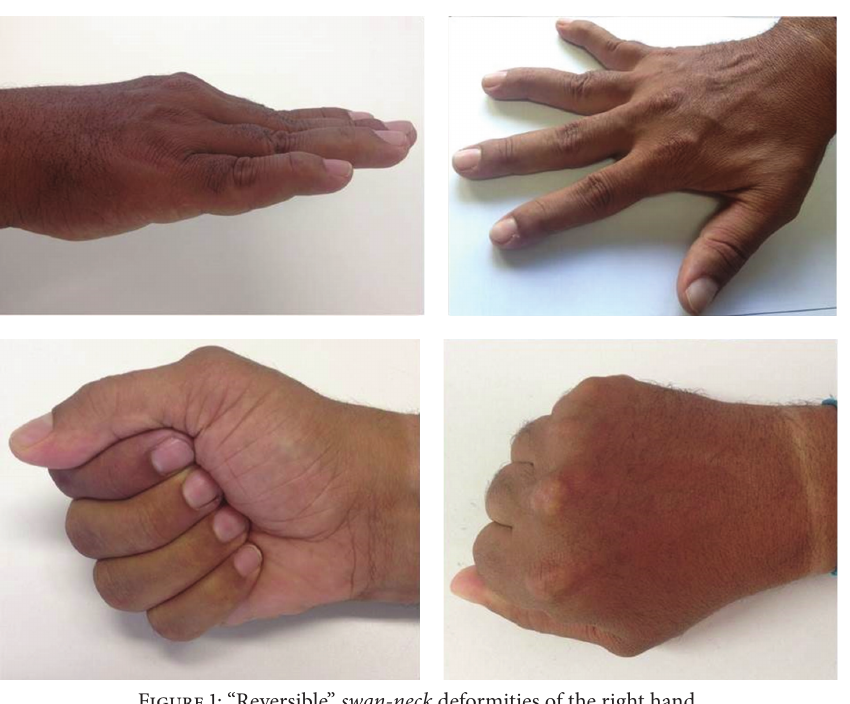
Figure 1: “Reversible” swan-neck deformities of the right hand.